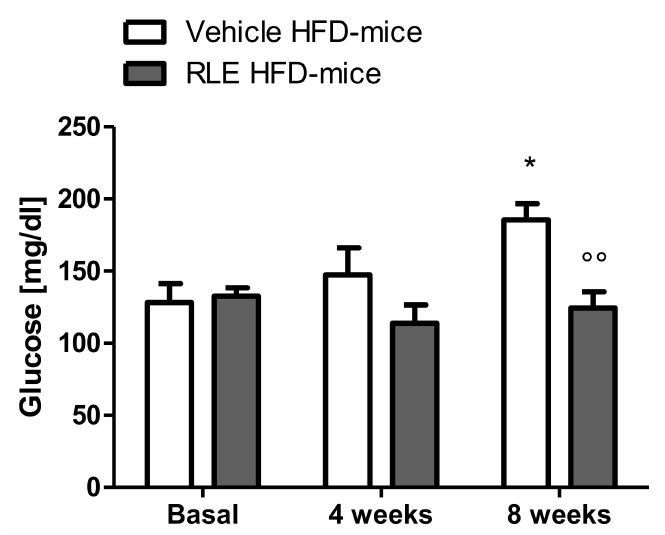
Figure 1. Eight weeks of RLE diet supplementation reduce glucose blood concentration in HFD-mice. RLE diet supplementation was able to block blood glucose level increase in CD1 mice fed on a high-fat diet (HFD-mice) after eight weeks of treatment. No significant differences were observed after four weeks of treatment with RLE. Data are means ± SEM of 9 to 12 mice per group. Two-way ANOVA followed by Bonferroni post-test. * p < 0.5 vs vehicle HFD-mice basal group; ◦◦ p < 0.1 vs vehicle HFD-mice 8 weeks group.